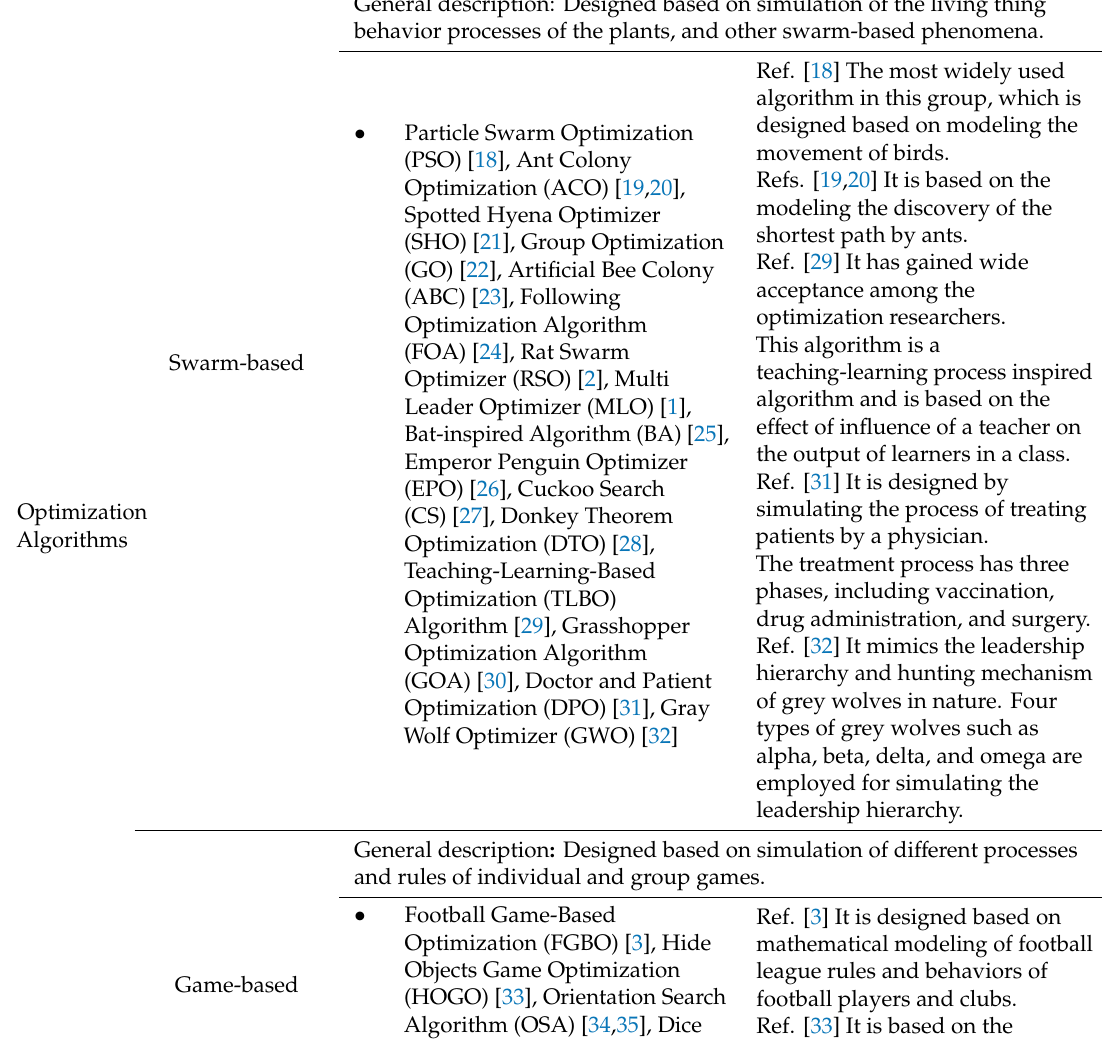
Table 1. Optimization